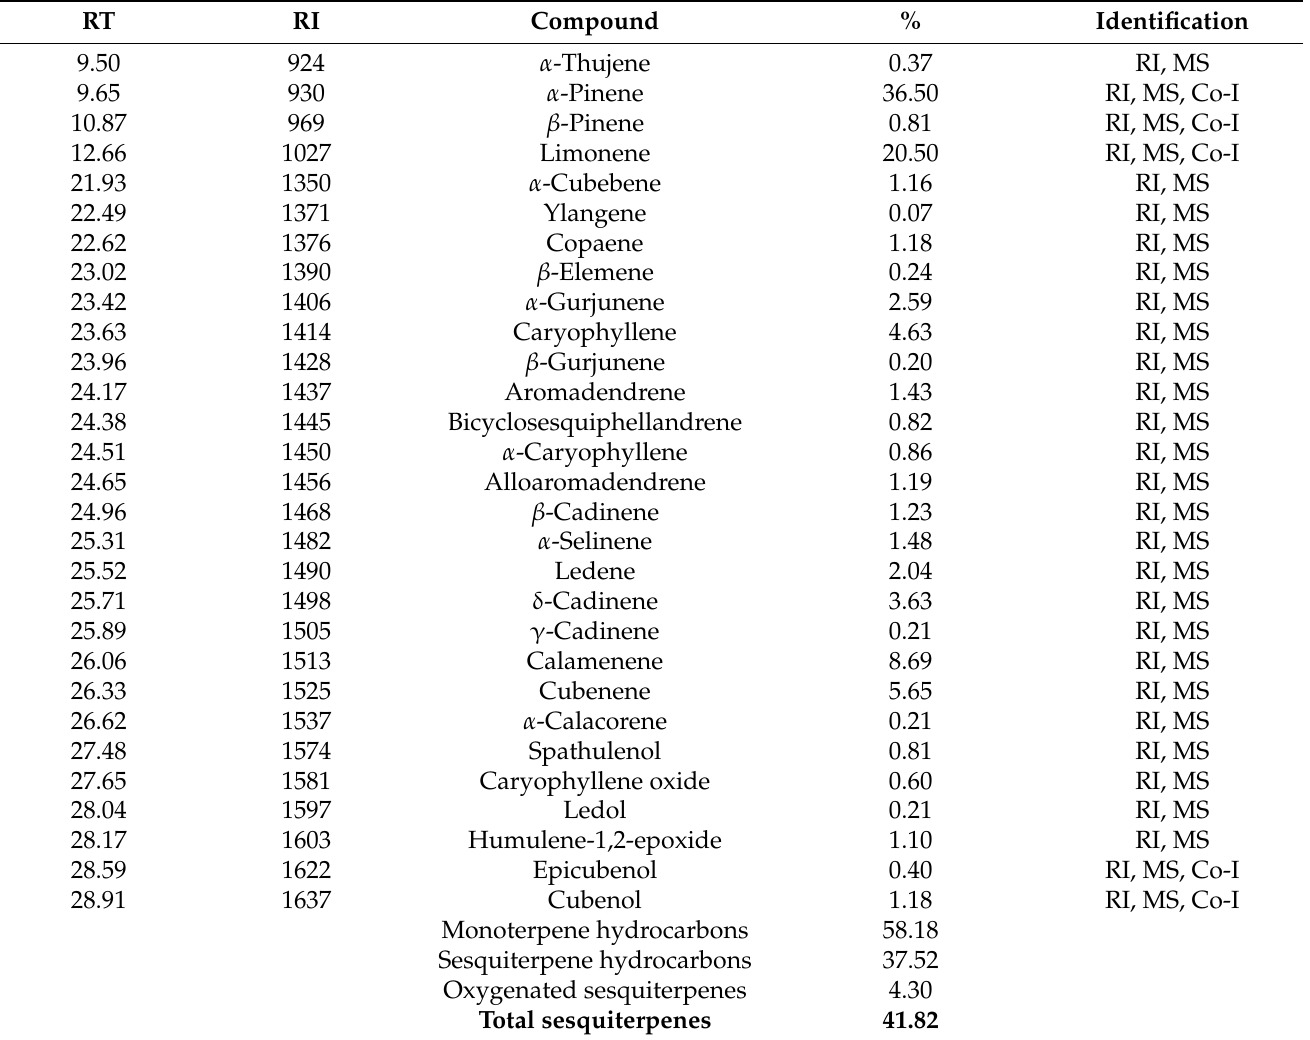
Table 1. Chemical composition of the B. cruckchanksii leaves essential oil